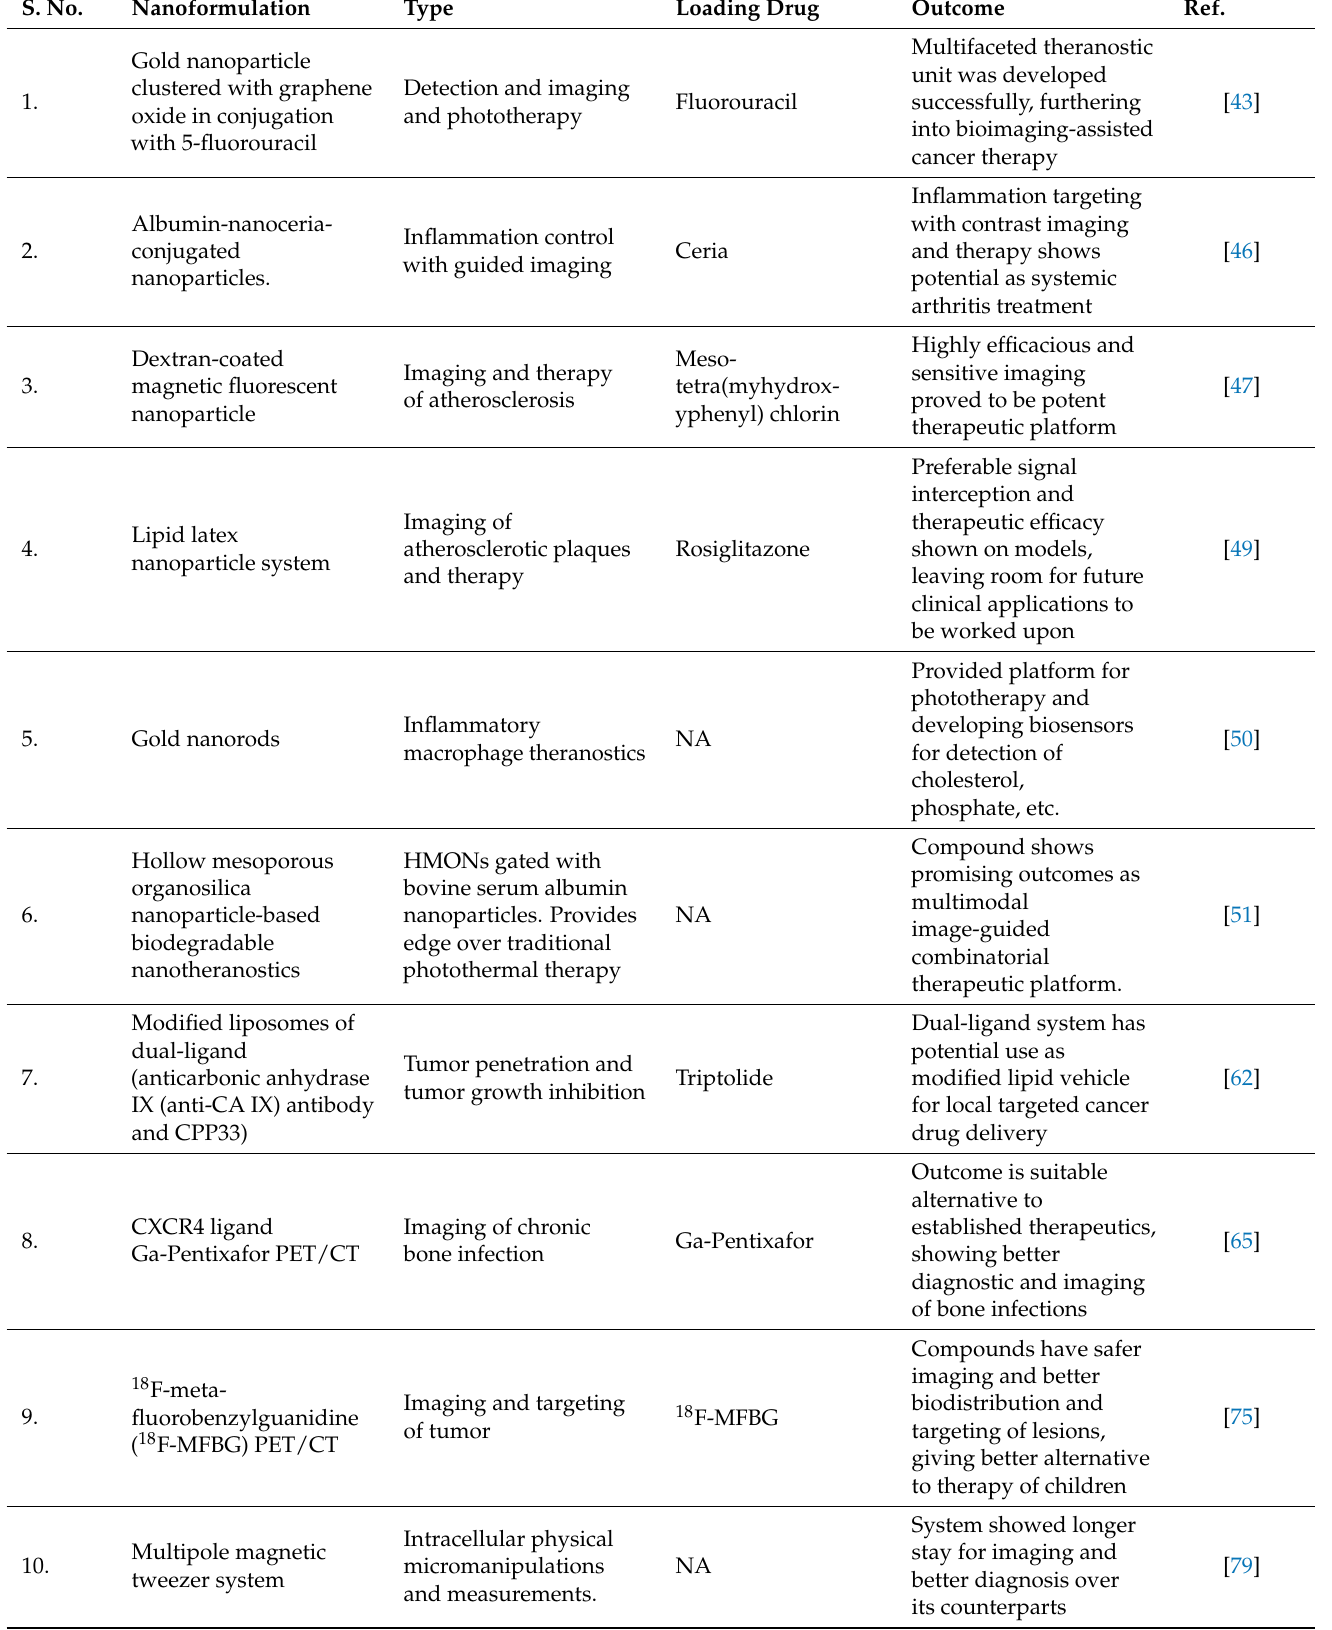
Table 2. Nanotheranostics approaches applied in past and current